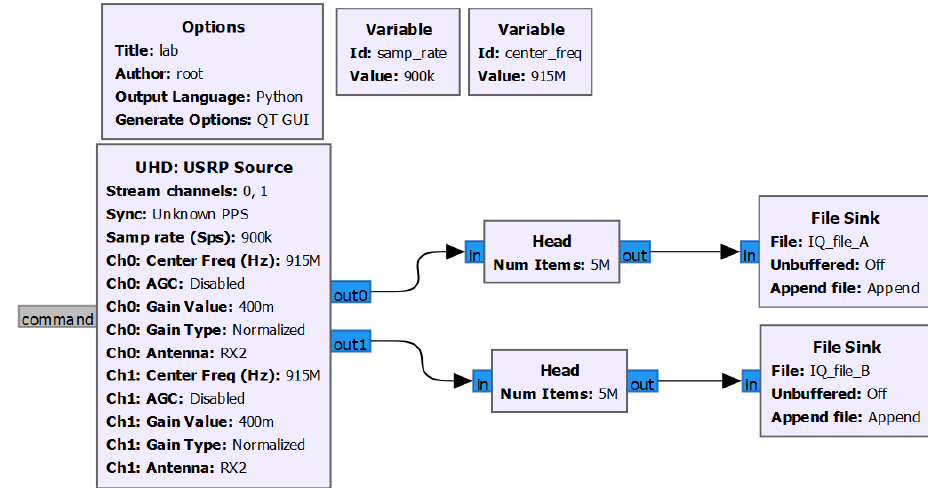
Figure 11. Flow chart of the signal received by GnuRadio.